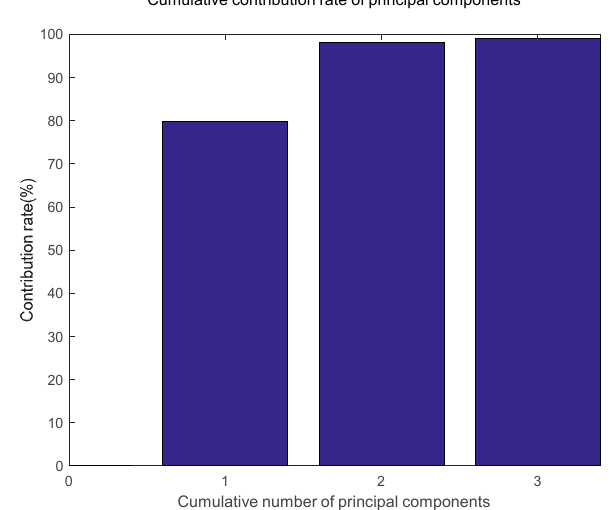
Figure 7. Cumulative contribution rate of principal component.